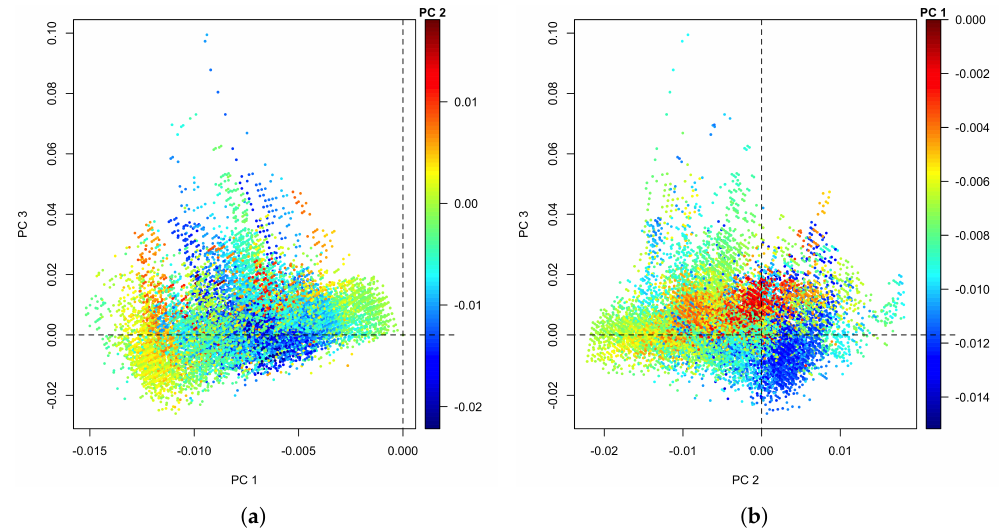
Figure 7. ( a ) Principal components PC 3 against PC 1 for the validation data, colour-coded by PC 2 ; ( b ) the same but PC 3 against PC 2 colour-coded by PC 1 .